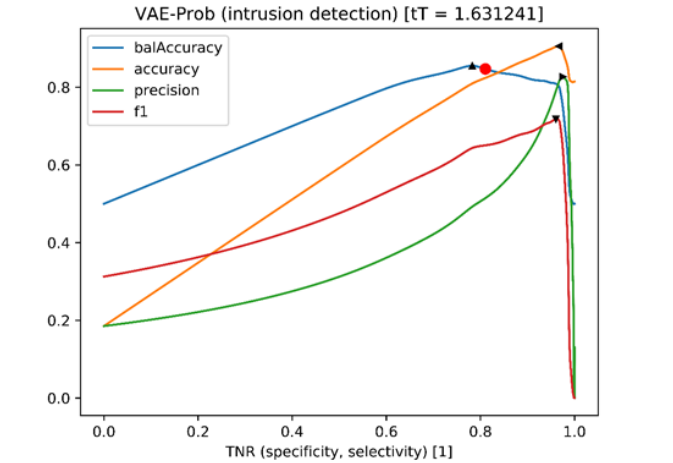
Figure 6. Results for the probability-based variational autoencoder.